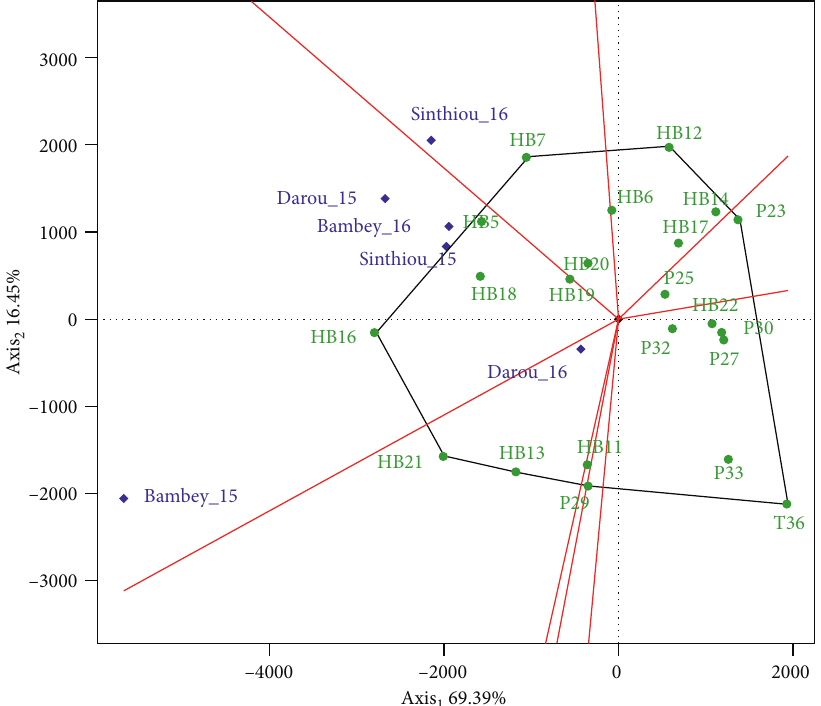
Figure 4: “Which-won-where” view of best grain mold resistant inbred lines and hybrid combinations based on grain yield. Red lines represent the megaenvironments; hybrids and inbred lines labels are written in green; locations labels are written in blue; dotted lines represent the